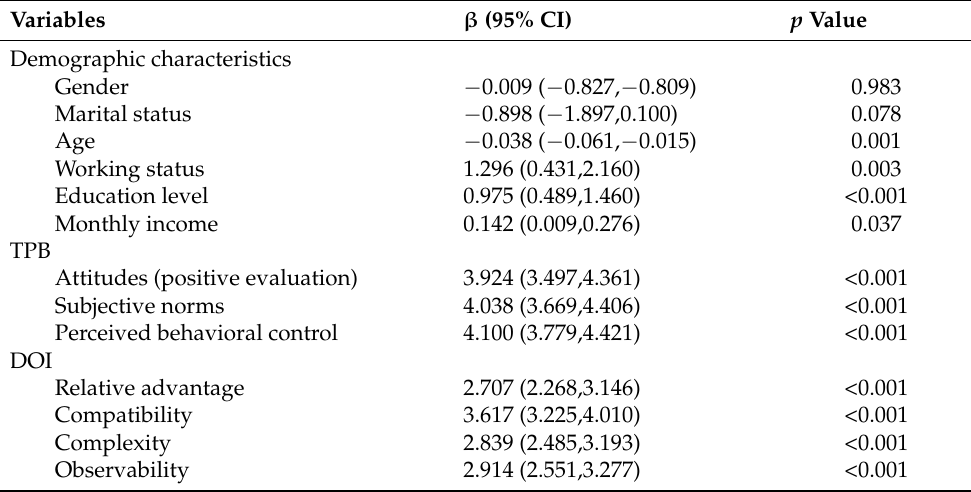
Table 4. Univariate analysis of willingness to use wearable health